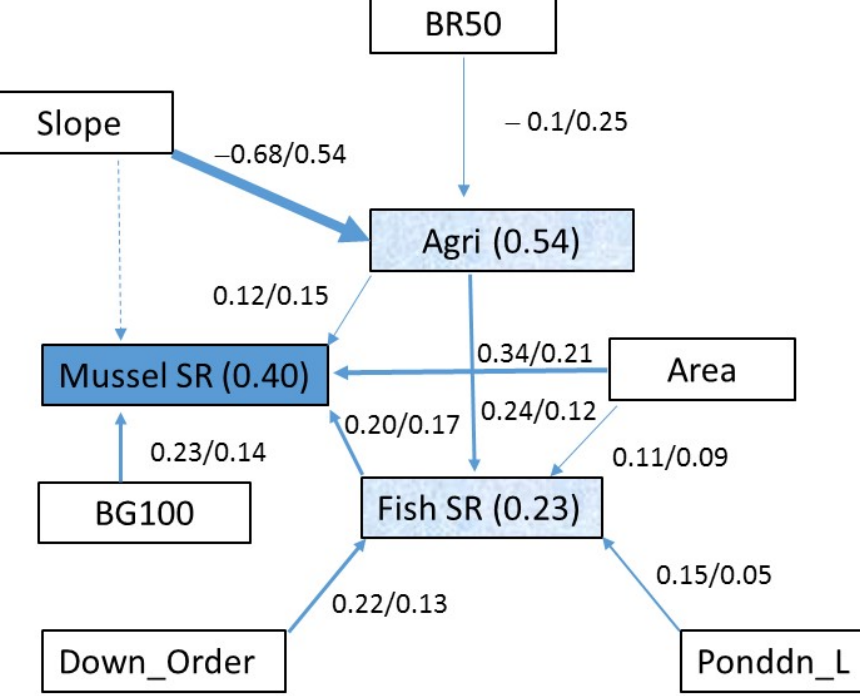
Figure 1. The paths of SEM show the standardized regression coefficient vs. marginal R 2 of individual physical predictors (x/y) for each of the three response variables across 459 stream sites in Illinois. Mussel SR is the ultimate response variable (blue). Fish species richness (SR) and percent agricultural land in the watershed (Agri) are response variables of other environmental factors, as well as the predictors of mussel SR (light blue). All other variables are predictors (blanks) (Down_Order = order of downstream reach, Ponddn_L = distance from downstream pond, see Table 1 for the abbreviations of other predictors). The R 2 for the overall model is shown in each of the blue boxes (see [6] for data sources), and its value is symbolized by the width of the arrow (solid line = statistically significant; dotted line = insignificant).